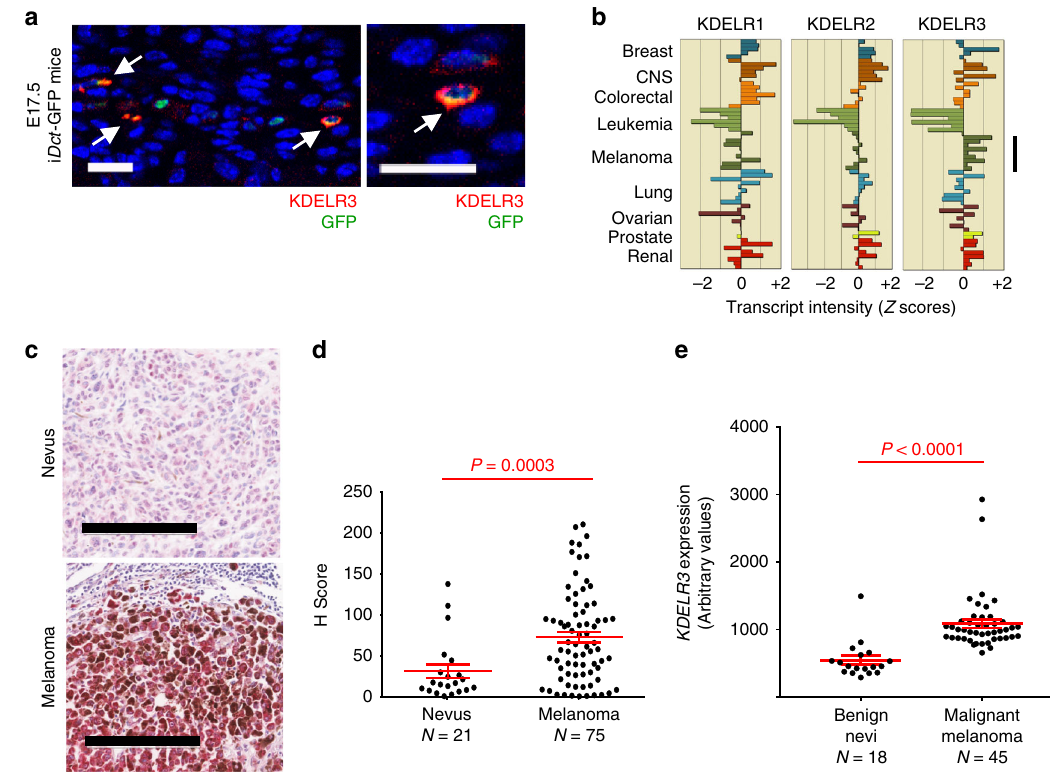
Fig. 2 Melanoblast gene expression in melanoma. a KDELR3 (red) and GFP (green) staining in E17.5 i Dct -GFP mouse skin. White arrows depict co- localization. Magni fi cation, ×40. Scale bars, 20 µ m. Representative image of 100 cells analyzed taken from one mouse. b Pan-cancer RNA expression of KDEL receptors in human cell lines (NCI60, CellMiner analysis); KDELR3 expression in melanoma (black line). c KDELR3 expression in human nevus and melanoma lymph node metastasis (red intercellular staining), magni fi cation, ×10. Scale bar represents 200 µ m. d H score of KDELR3 immunohistochemistry in human tumor microarrays. Unpaired two-tailed Student ’ s t test with Welch ’ s correction, P = 0.0003, d.f. = 47.9, t = 3.936. N = 21 (nevus) and N = 75 (melanoma). e KDELR3 expression in benign nevi and malignant melanoma (GSE3189; 204017_at probeset). Unpaired two-tailed Student ’ s t test with Welch ’ s correction, P <0.0001, d.f. = 47.39, t = 6.035. N = 18 (benign nevi) and N = 45 (malignant melanoma). d , e Line and error bars represent mean± s.